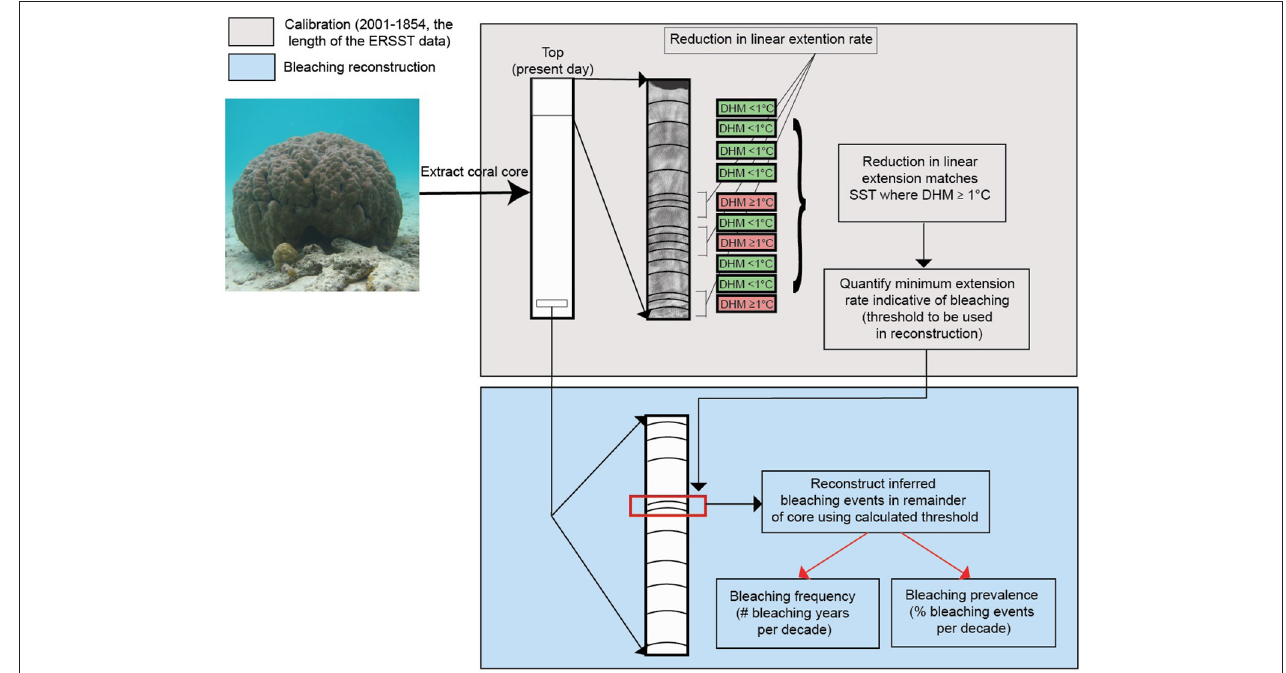
FIGURE 2 | Methodology workflow. Coral linear extension obtained from databases as detailed in methods. The upper gray box illustrates reconstructed bleaching calibration process using ERSST data, DHM ( ◦ C) indicates degree heating months. The lower blue box illustrates reconstruction of